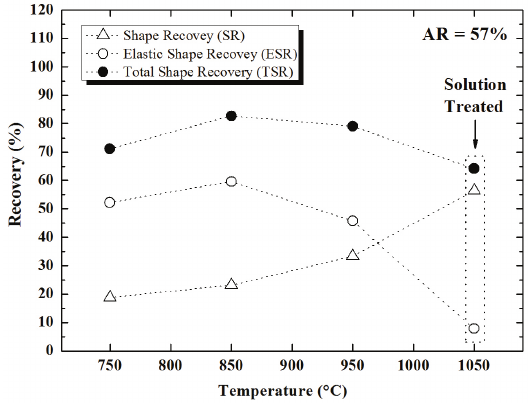
Figure 5. Elastic Shape Recovery (ER), Shape Recovery (SR) and Total Shape Recovery (TSR) as a function of annealing